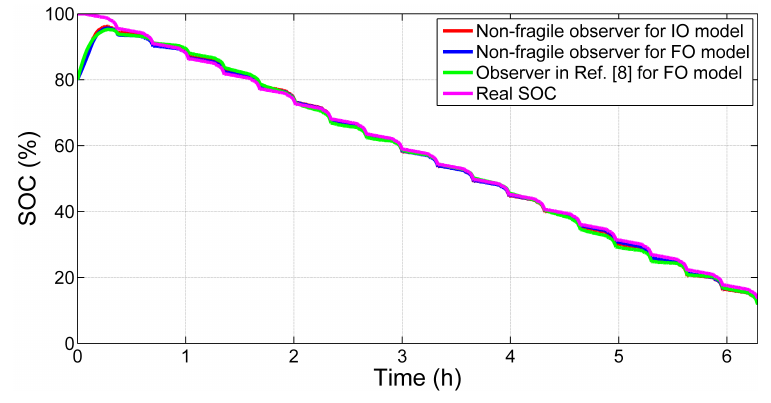
Figure 10. SOC estimation profiles for NEDC.